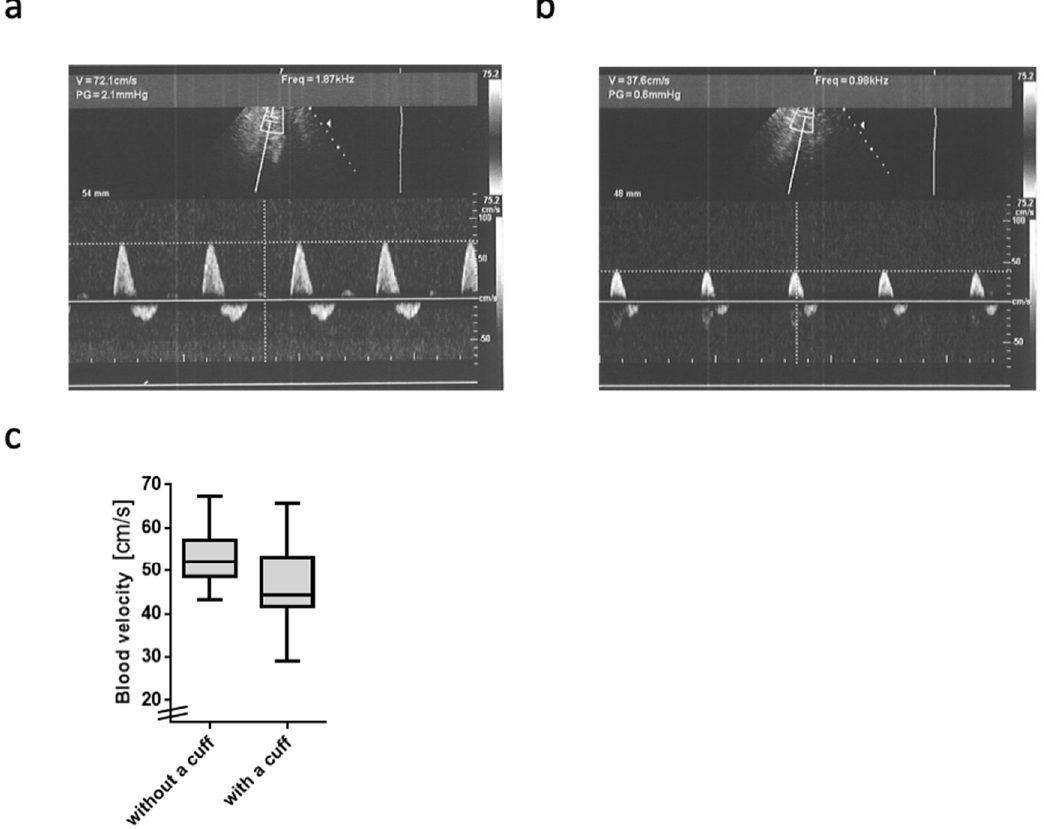
Figure 1. Blood flow velocity in the A. poplitea: ( a , b ) Representative original Doppler sonography blood flow profiles at rest: The upper images show the region of interest of the A.poplitea; the lower diagrams show the time course on the x-axis and the blood flow velocity heartbeat by heartbeat on the y-axis. ( a ) Blood flow velocity without wearing a cuff. ( b ) Blood flow velocity while wearing the cuff (occlusion pressure 300 mm Hg). ( c ) Boxplots of the grouped pre-post differences in blood flow velocity with and without cuff. Data are displayed as median and inter-quartile ranges plus range (whisker bars).